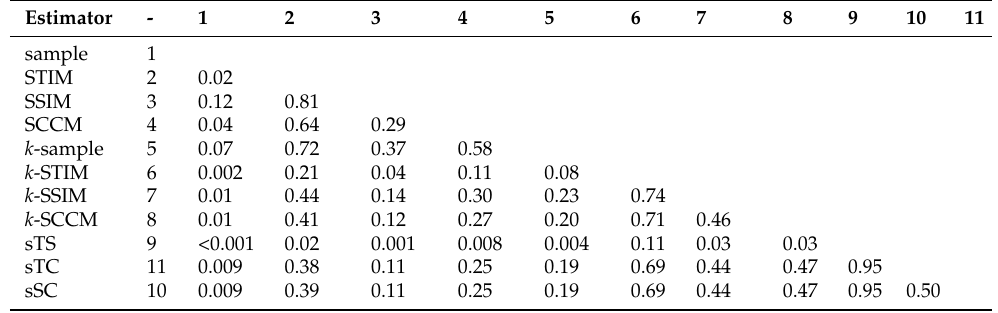
Table A4. p -Value of the annual volatility for each pair of covariance estimators in Table 3.